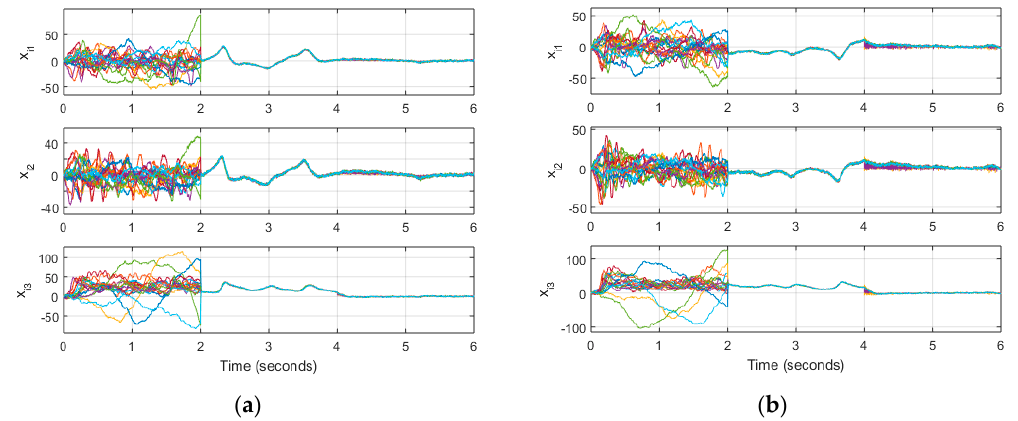
Figure 11. Complex network node dynamics when there are two controlled nodes, there is noise in the system and: ( a ) Control input is applied every 5T with control gains d 3 = d 4 = 700; ( b ) Control input is applied every 10T with control gains d 3 = d 4 = 1200 .